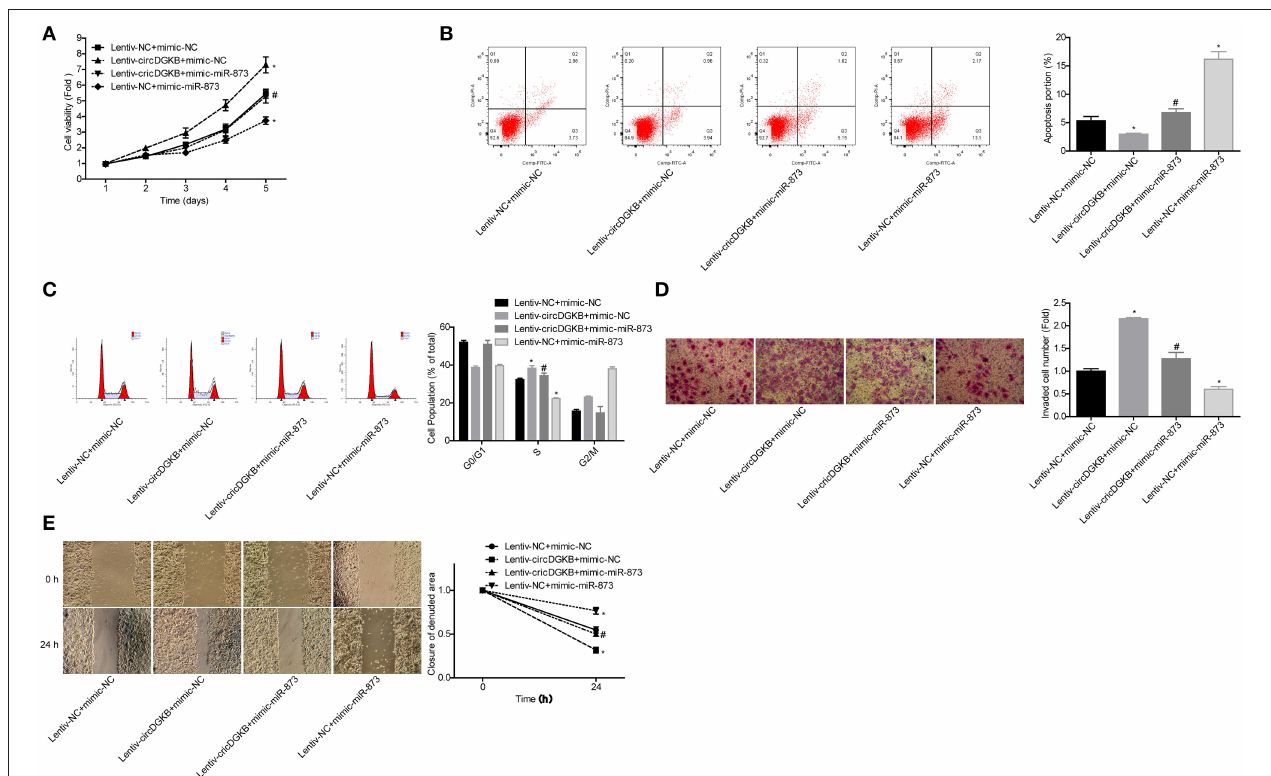
FIGURE 6 | circDGKB promoted NB progression by targeting miR-873. (A) Proliferation of SK-N-SH cells was detected by CCK-8 assay. (B) Apoptosis of SK-N-SH cells was detected by flow cytometry. (C) Cell cycle of SK-N-SH cells was assessed by flow cytometry. (D) Cell invasion and (E) migration were determined by transwell experiment and wound healing assay in SK-N-SH cells. (* P < 0.05, vs. Lentiv-NC + mimic-NC group, # P < 0.05, vs. Lentiv-circDGKB + mimic-NC